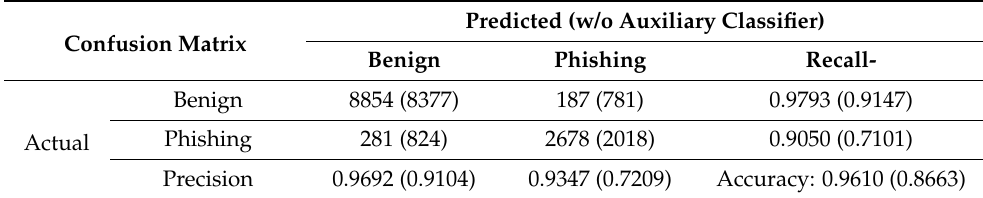
Table 5. Confusion matrix analysis to verify the effectiveness of the auxiliary